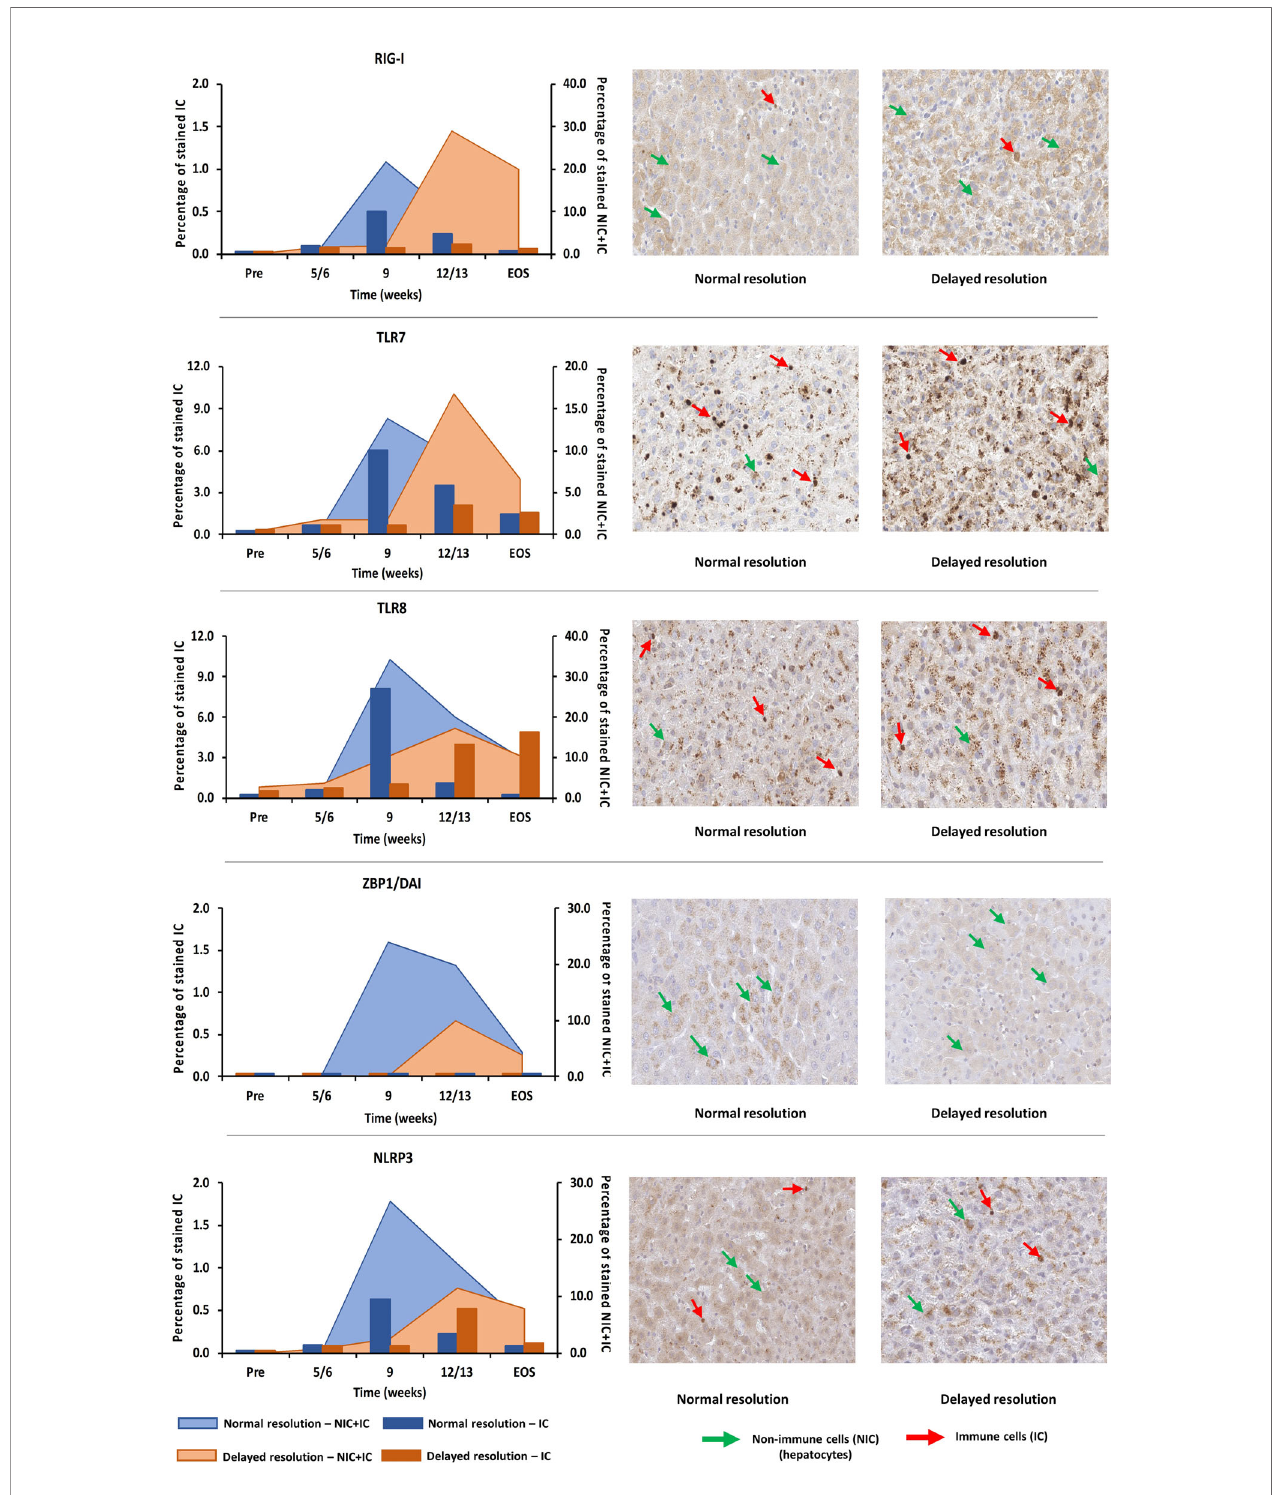
FIGURE 9 | Intrahepatic presence of selected PRRs. Liver tissues from one representative woodchuck each during AHB with normal (M7392) or delayed resolution (M7249) were stained for viral RNA (RIG-I, TLR7, and TLR8) and viral DNA sensing receptors (ZBP1/DAI and NLRP3) using cross-reactive antibodies. The kinetics in the percentage of positively stained cells are presented (left panels). The percentage of stained immune and non-immune cells is plotted on the right y-axis, while the percentage of stained immune cells is plotted on the left y-axis. Representative staining images for the cellular and sub-cellular localization of receptors are shown (right panels). Pre, pre-inoculation; EOS, end of study; NIC, non-immune cells; IC, immune